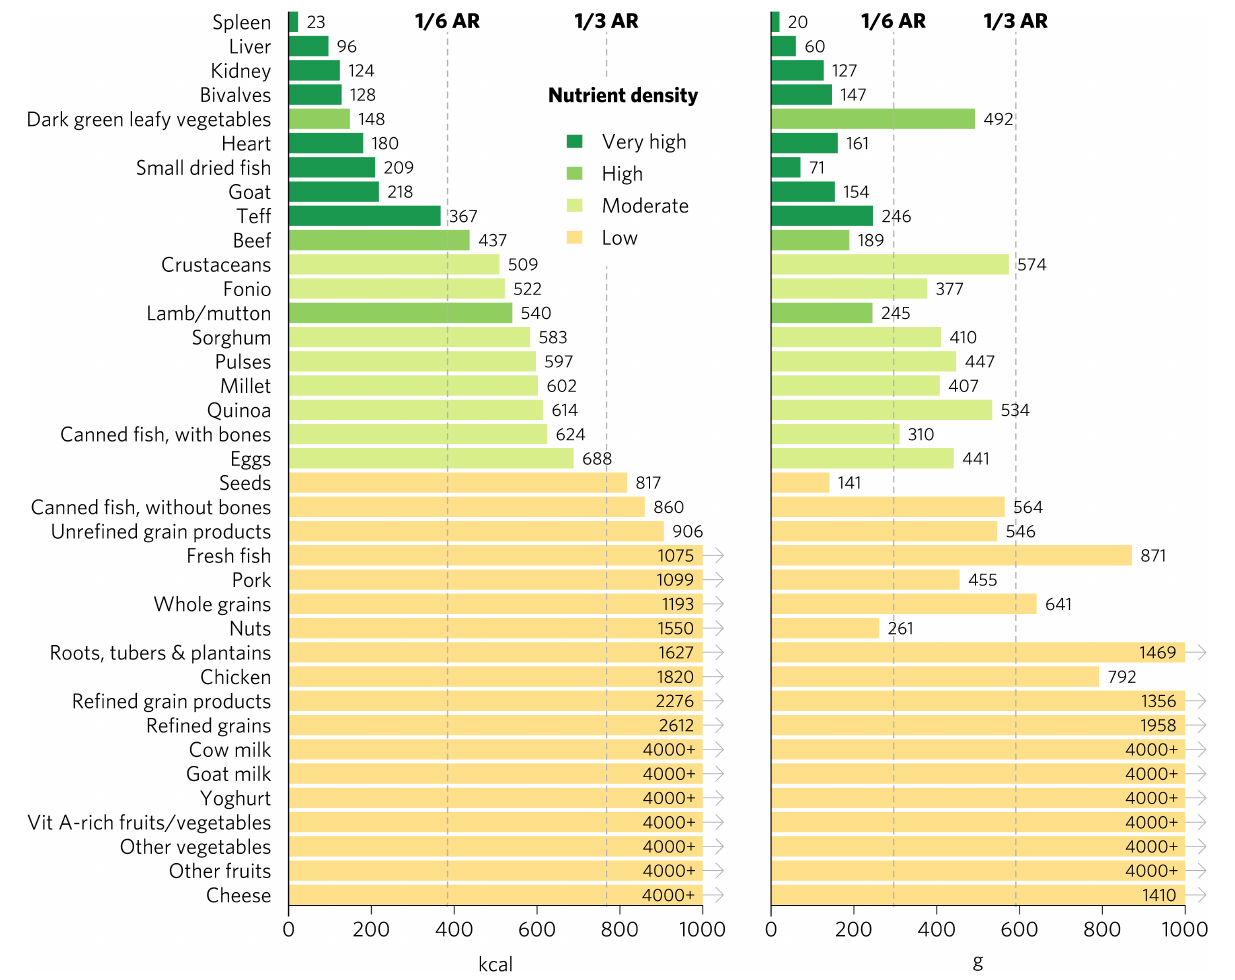
rated high for children 2–4 years but low for all other